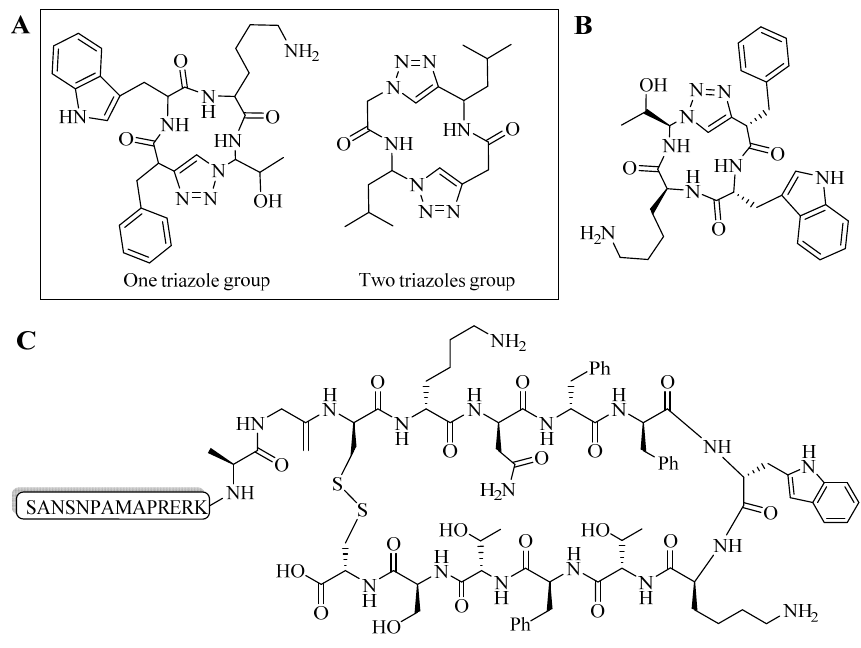
somatostatin receptor binding